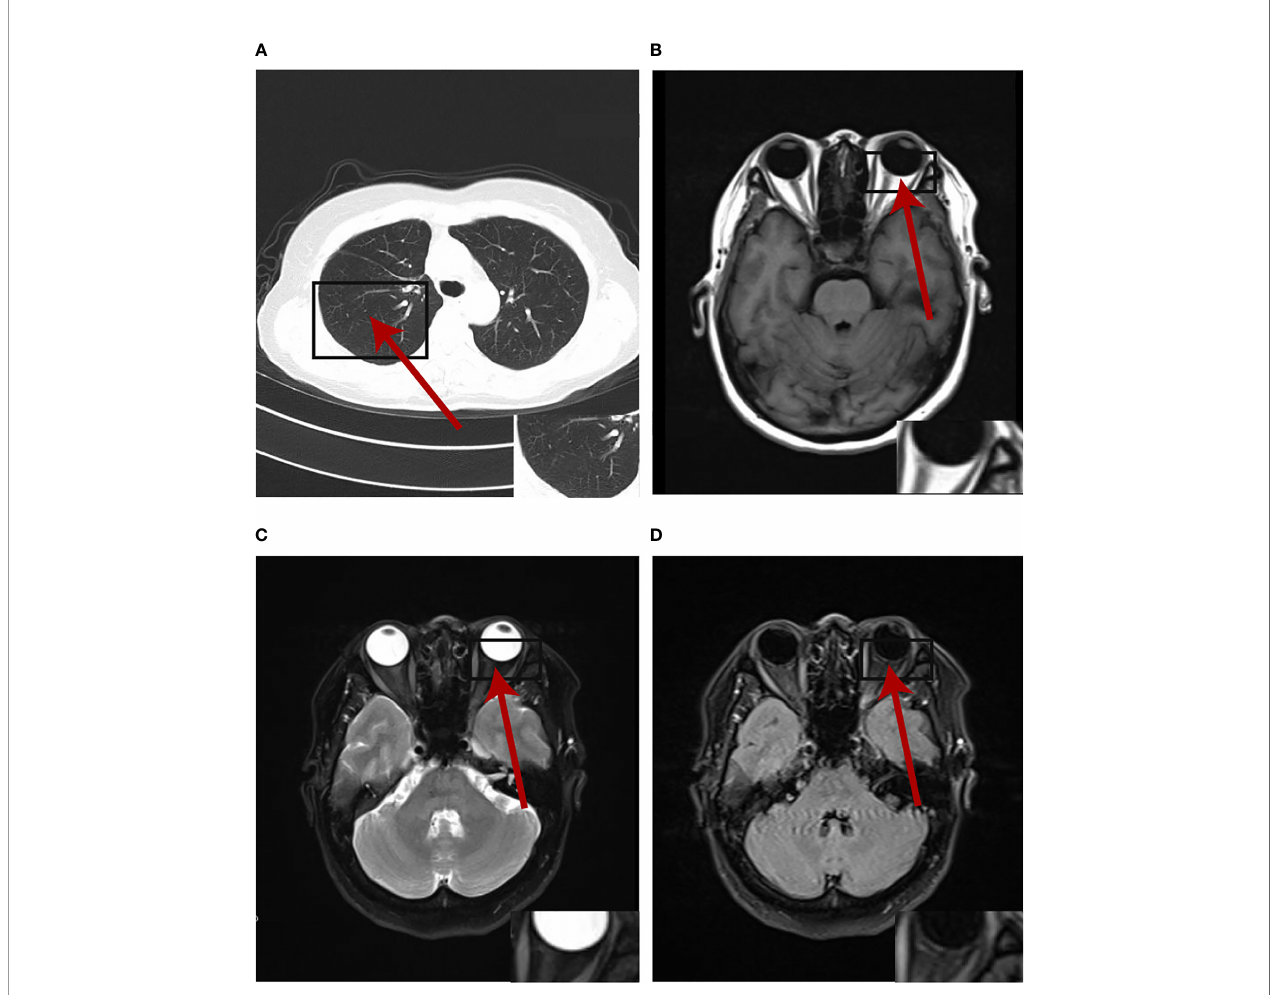
FIGURE 4 | The primary lesion and oligogenous metastases were complete response by the patient's latest (August 2021) chest CT and cranial MRI at the time of